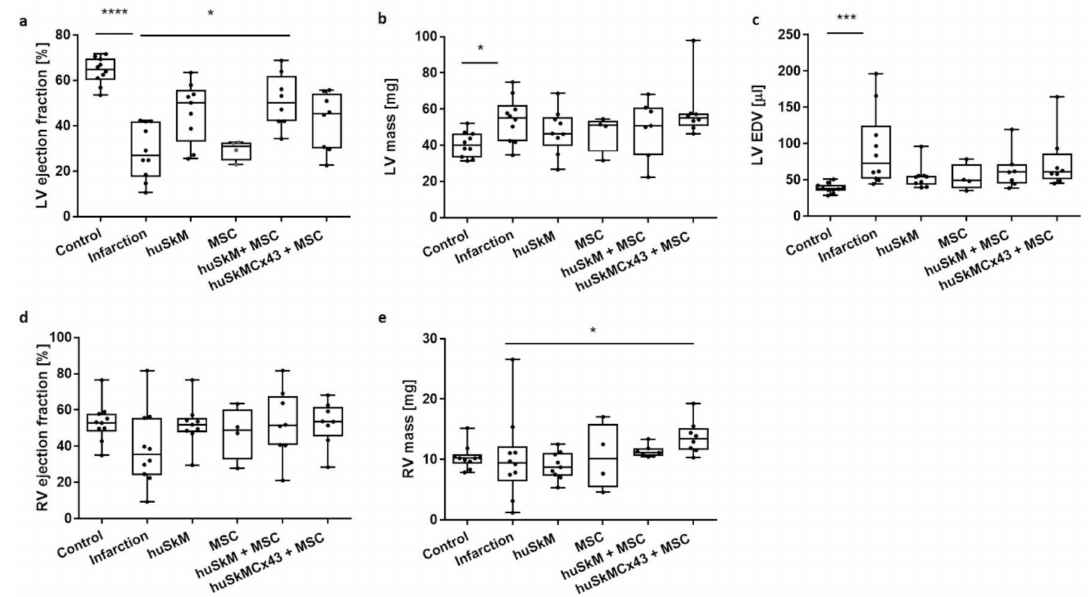
Figure 9. Functional analysis of cardiac haemodynamics after huSkM ( n = 4), MSCs ( n = 4), huSkM+MSC ( n = 8 and huSkMCx43+MSC ( n = 8) cells intervention compared to the control-healthy hearts ( n = 10) and MI ( n = 5). ( a ). left ventricle ejection fraction (LV ejection fraction), ( b ). left ventricle mass (LV mass), ( c ). left ventricle end-diastolic volume (LV EDV), ( d ). right ventricle ejection fraction (RV ejection fraction) and ( e ). right ventricle mass (RV mass). Box represents 25th–75th percentile, line represents the median, whiskers are min to max, single values are presented as dots. * p < 0.05, *** p < 0.001, **** p < 0.0001, Kruskal-Wallis test followed by Dunn’s multiple comparisons